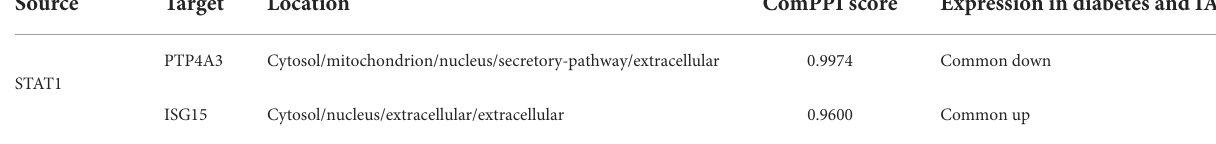
TABLE 2 Protein information of PTP4A3 and ISG15 obtained from the ComPPI database. Source Target Location ComPPI score Expression in diabetes and IA PTP4A3 Cytosol/mitochondrion/nucleus/secretory-pathway/extracellular 0.9974 Common down STAT1 ISG15 Cytosol/nucleus/extracellular/extracellular 0.9600 Common